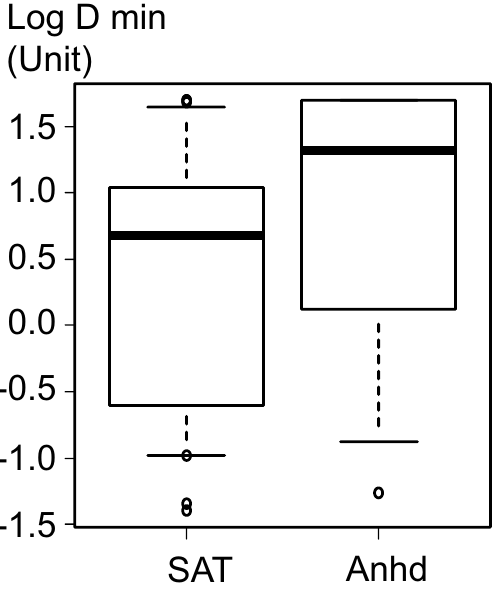
Figure 2. Log D min between SAT (conventional sweat allergy-type CholU and CholU with palpebral angioedema) and CholU with acquired anhidrosis and/or hypohidrosis. Anhd acquired anhidrosis and/or hypohidrosis, D min cumulative dose of inhaled methacholine when respiratory resistance began to increase, SAT sweat allergy